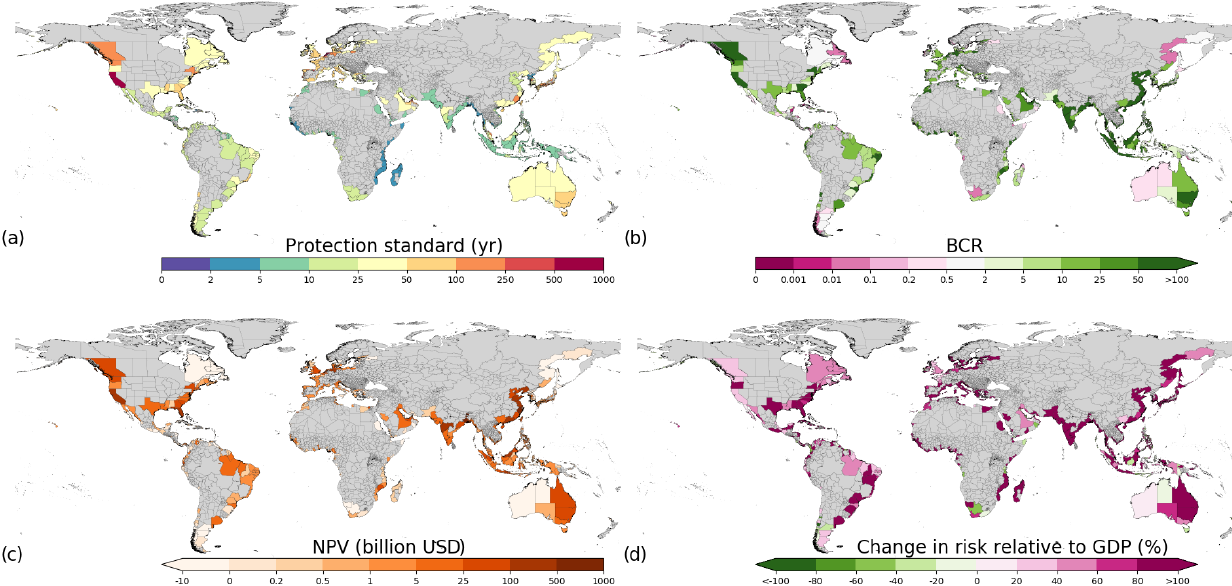
Figure 5. Protection constant adaptation objective results of (a) protection standards, (b) BCRs, (c) total NPV, and (d) change in risk relative to GDP for RCP4.5–SSP2. Note that the protection standards (a) are the same as FLOPROS estimates. Regions with no data are indicated in